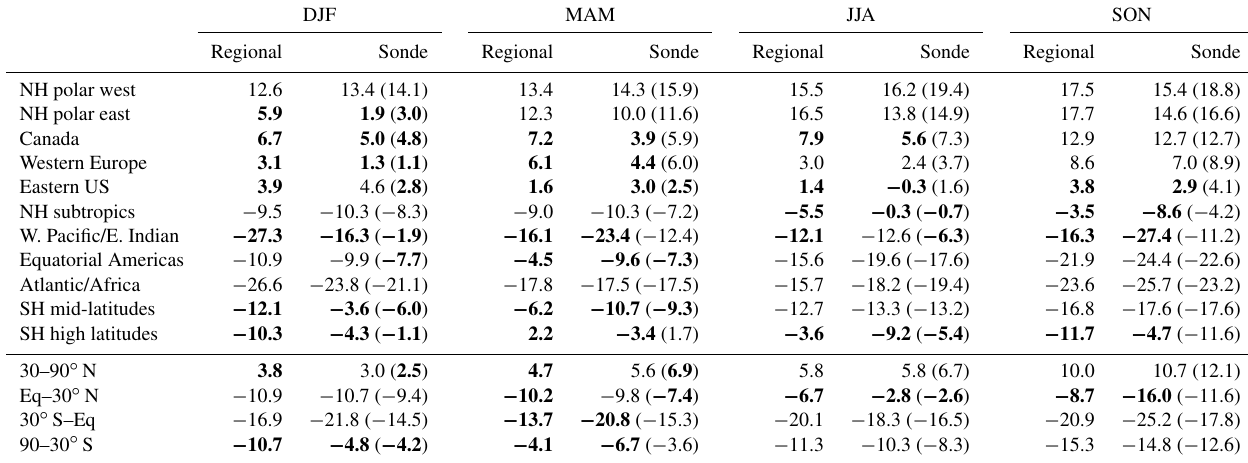
Table 8. Median of the ACCMIP models minus reanalysis at 500hPa (in % relative to the reanalysis concentrations). Results presented include the regional averages (Regional) for the ozonesonde temporal–spatial sampling using 2-hourly reanalysis fields (Sonde) and for the ozonesonde spatial sampling using monthly reanalysis fields (in brackets). Relative differences between the two estimates larger than 30% are shown in